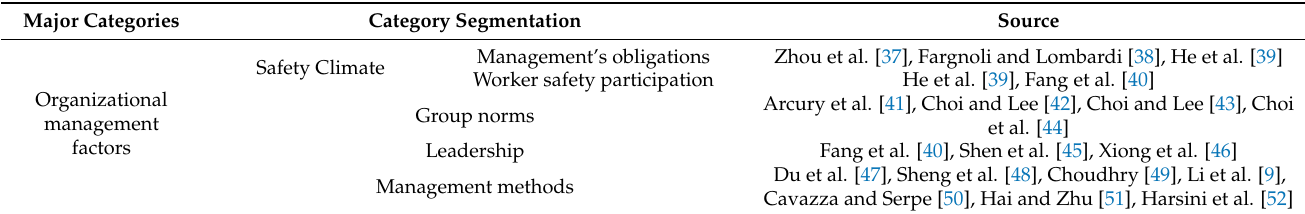
Table 3. Organizational management